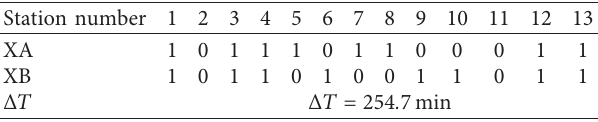
Table 2: Optimization results of A and B train parking